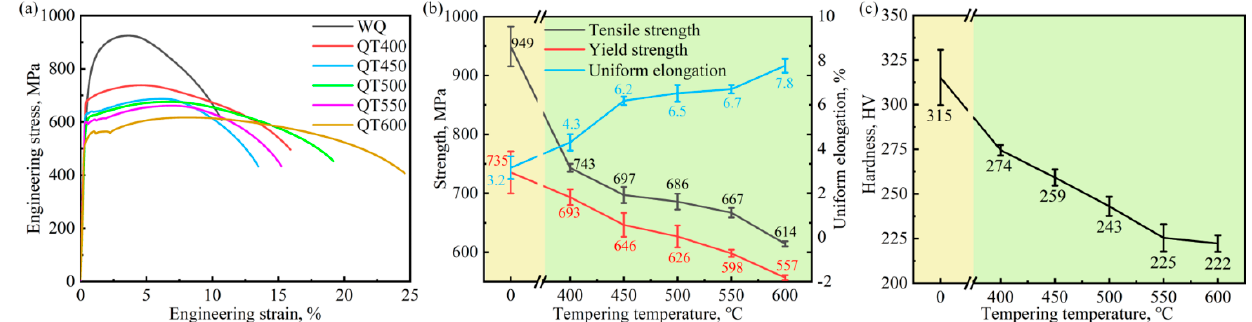
Figure 2. ( a ) Engineering stress–strain curves, ( b ) strength and elongation, ( c ) hardness of the specimens after different heat treatments.